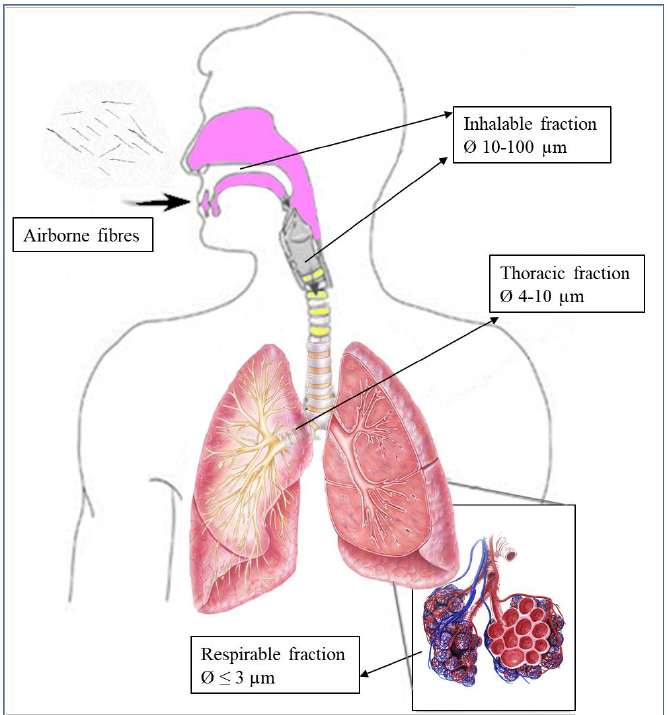
Figure 2. Size-selective inhalation of airborne fibres involves specific regions of the respiratory tract. Different studies conducted in vitro and in vivo showed that particles not covered by the dimensions suggested by the WHO could even trigger pathological effects when in- haled or ingested. In this respect, from the beginning of the 1970s, several studies have been conducted considering amphiboles with different geometrical ratios (Table 1). How-